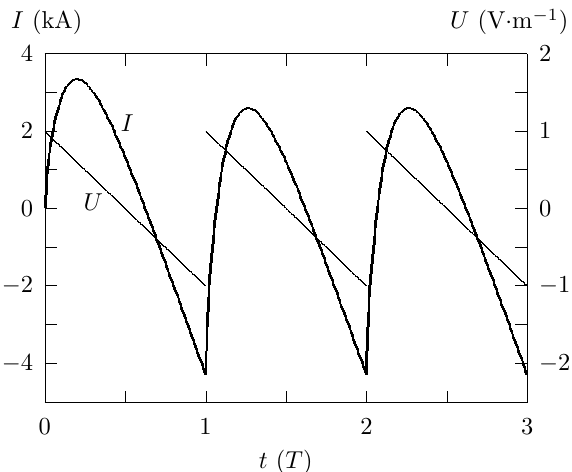
Figure 7. Example 4, d = 16 mm, f = 60 Hz, ˆ U = 1 V conductor A 1 and the voltage U on time t